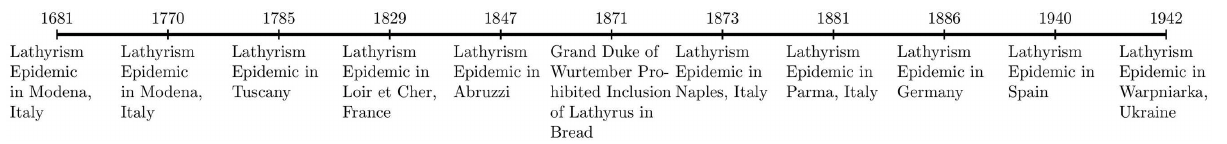
FIGURE 5 | Timeline of historical lathyrism epidemics.